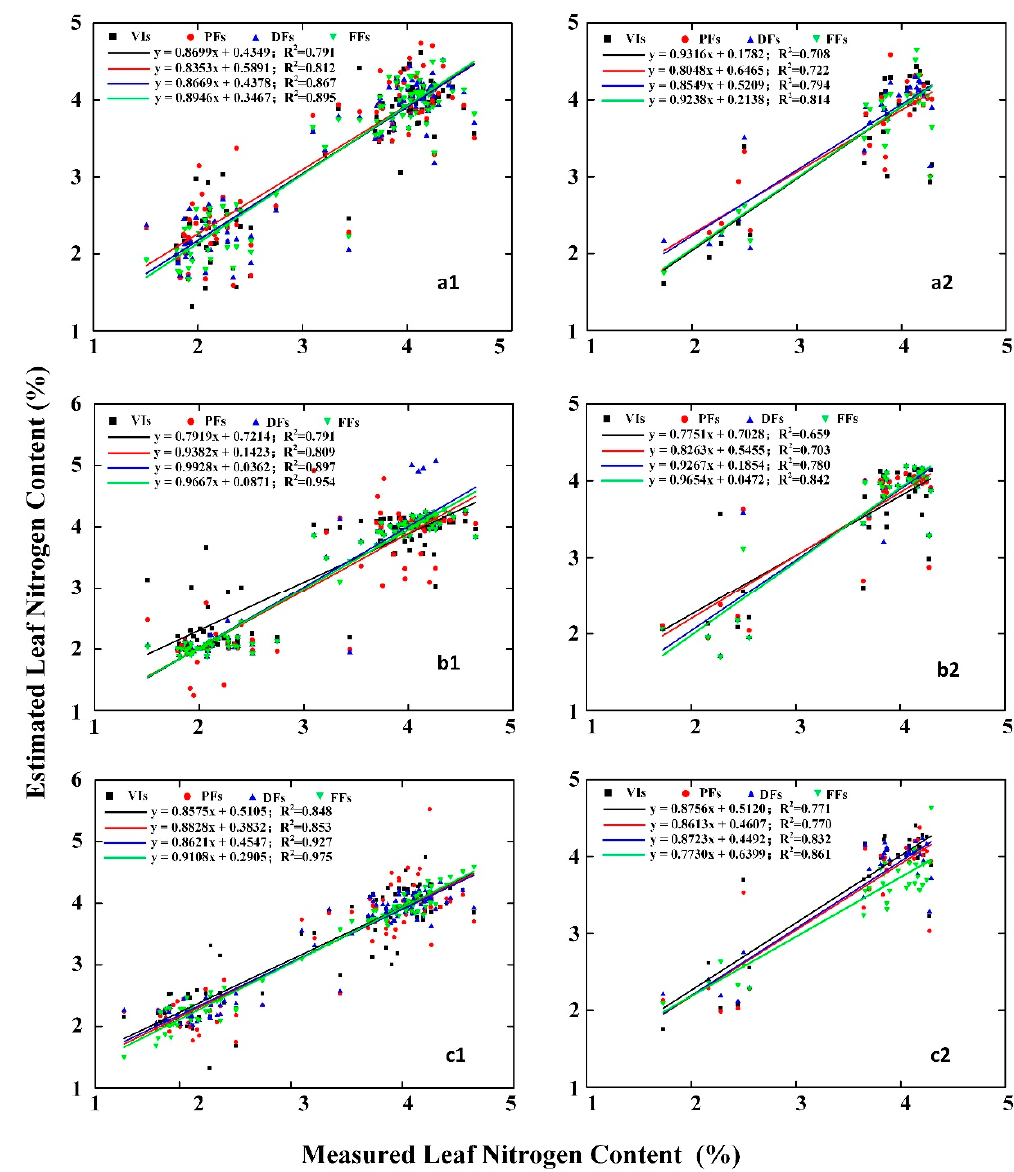
Figure 7. Estimated and measured leaf nitrogen content (%) in wheat. Left: validation set, right: calibration set with PLS ( a1 , a2 ), SVR ( b1 , b2 ), and GBDT ( c1 , c2 ). VIs: vegetation indices, PFs: position features, DFs: deep features, FFs: fusion features.